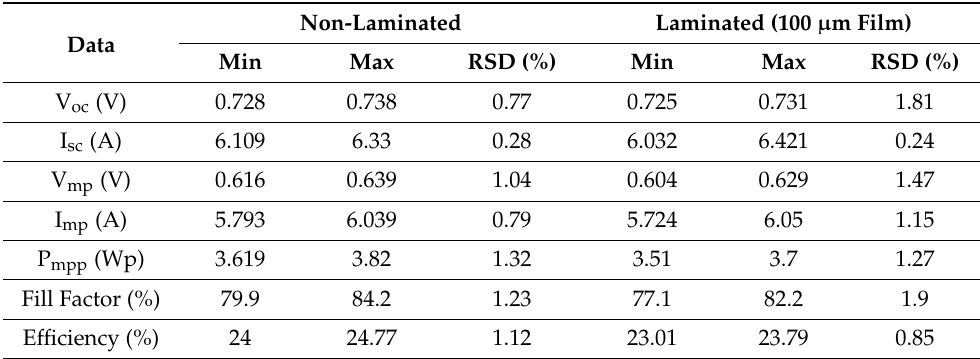
Table 4. Specification of tested SunPower Maxeon Ne3 solar cells.